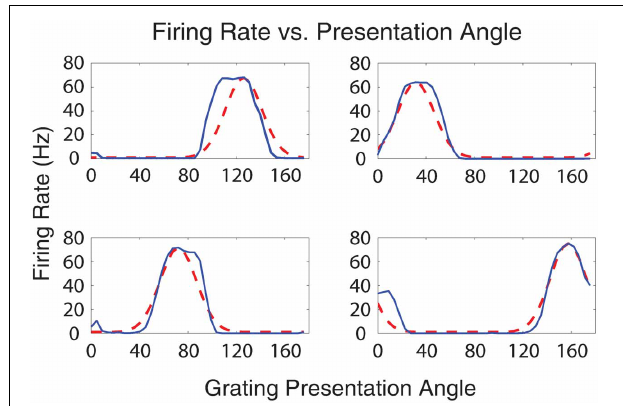
FIGURE 5 | Plot of the firing rate response of Exc group neurons vs. grating presentation orientation angle. The blue lines indicate the firing rate of a neuron in the simulation while the dotted red lines indicate idealized Gaussian tuning curves. Together, the four excitatory neurons cover the stimulus space of all the possible presentation angles.